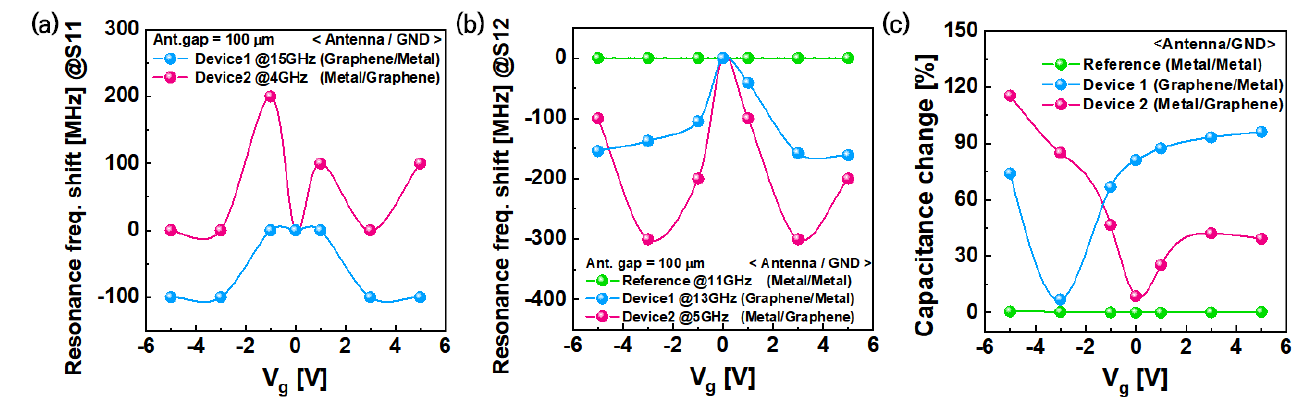
Figure 4. ( a ) For S11, the resonant frequency shift in reflectance is shown to be opposite when using graphene as an antenna and as a ground plane. As the graphene Fermi level increases in Device 1, the signal reflection in the low-frequency band increases. When the graphene Fermi level increases in Device 2, the signal reflection in the high-frequency band increases. Conversely, ( b ) for S12, all of the resonant frequency shifts were towards the lower frequency, exhibiting approximately twice the level of change in Device 1 compared to Device 2. ( c ) The capacitance variation according to the gate voltage change is plotted. When graphene is applied to the device, a capacitance change of approximately 120% is observed.